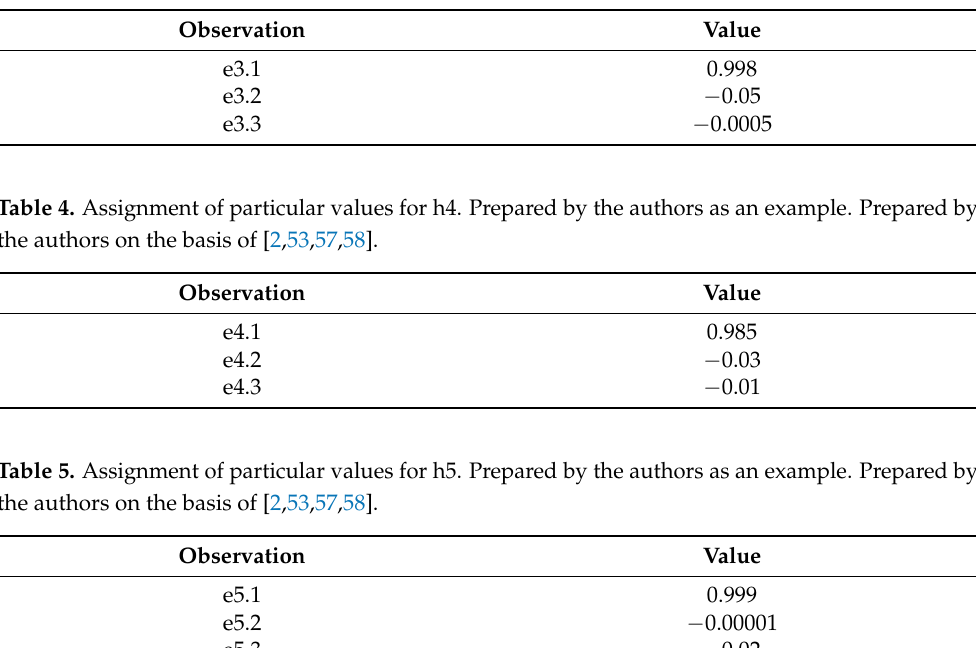
Table 3. Assignment of particular values for h3. Prepared by the authors on the basis of [2,53,55,56].